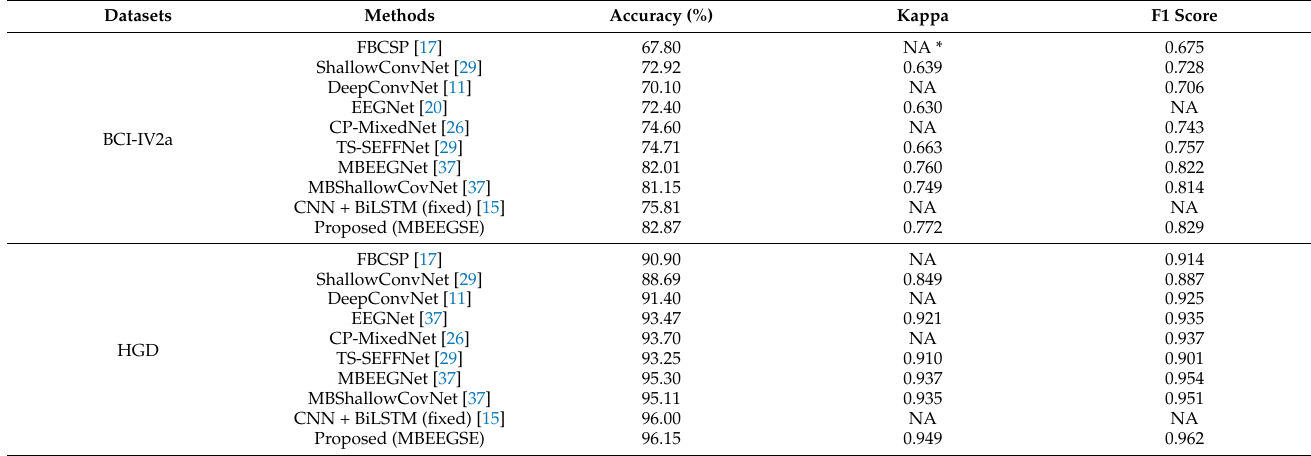
Table 2. The comparison summary of classification performance in proposed